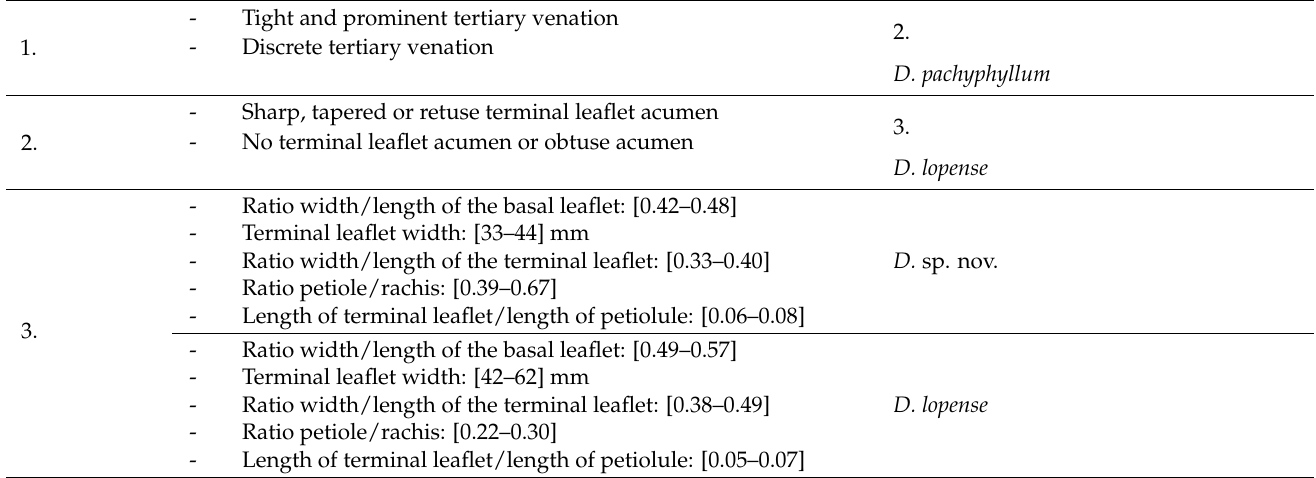
Table 6. Identification key for 3–5 leaflets Dialium species present in PW-CEB forests; on the left side of the table, the sections with the observable traits are presented; on the right side is either the species classification corresponding to the observed trait, or the reference of the section to continue the identification key; the range of values presented for the quantitative variables, in the third section, corresponds to the interval in which 50% of the observations made during this study occurs for each